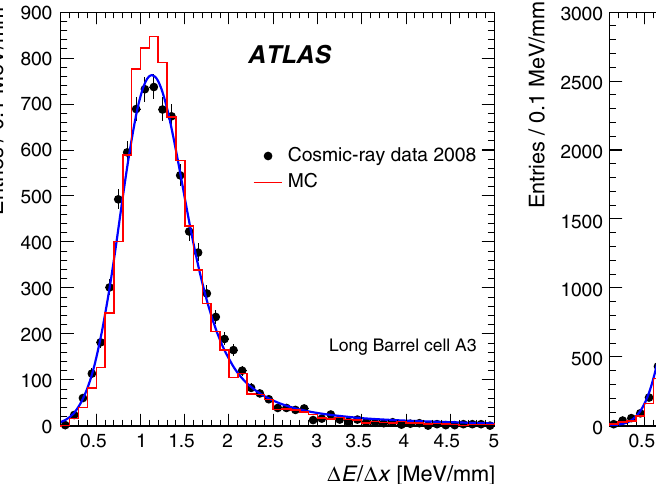
Fig. 22 Distributions of the energy deposited by cosmic muons per unit of path length, (cid:4) E /(cid:4) x , in the two cells in the long barrel, A3 (left) and D2 (right) obtained using 2008 experimental (full points) and simulated (solid lines) data. The A3 (D2) cell in the long barrel covers